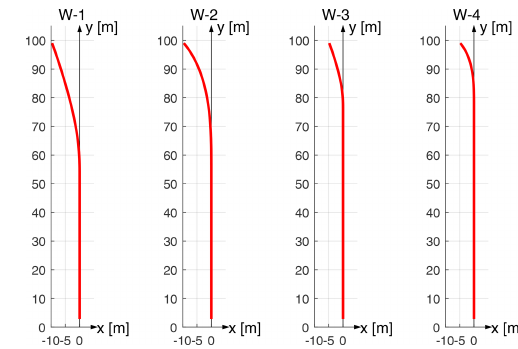
Figure 9. Side view of the main axes of the four different upwind dihedral blades used for the comparison. The dihedral blades from left to right are W-1 to W-4.